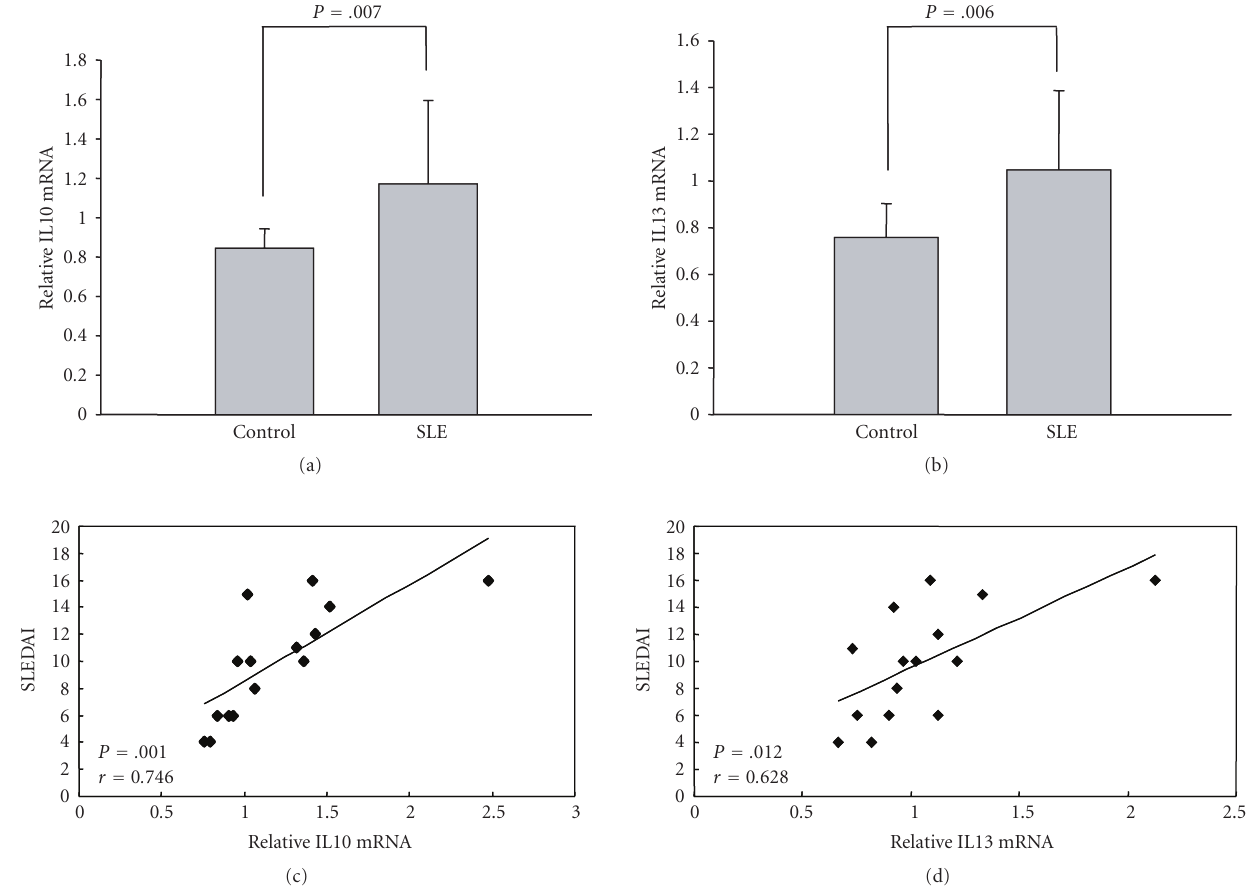
Figure 2: IL10 and IL13 mRNA expression in CD4 + T cells from SLE patients ( n = 15) and healthy controls ( n = 15) and the relationship between expression and disease activity. (a) and (b) IL10 and IL13 mRNA levels in CD4 + T cells were measured by quantitative real-time PCR and normalized to β -actin (SLE versus healthy control, P = . 007 and P = . 006, respectively). (c) In SLE patients, IL10 mRNA expression correlated ( r = 0 . 746) with SLEDAI score ( P = . 001). (d) IL13 mRNA expression also correlated with disease activity ( r = 0 . 628, P = .